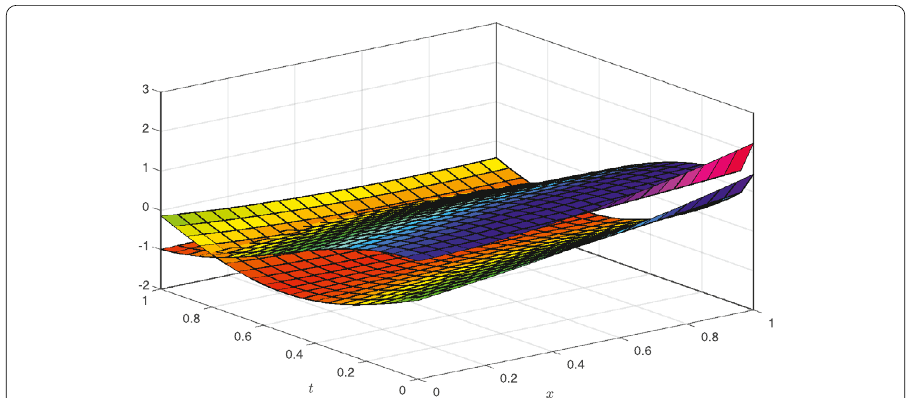
Figure 11 The approximate solution of Example 2 for Case 2 and α = β = 0.75